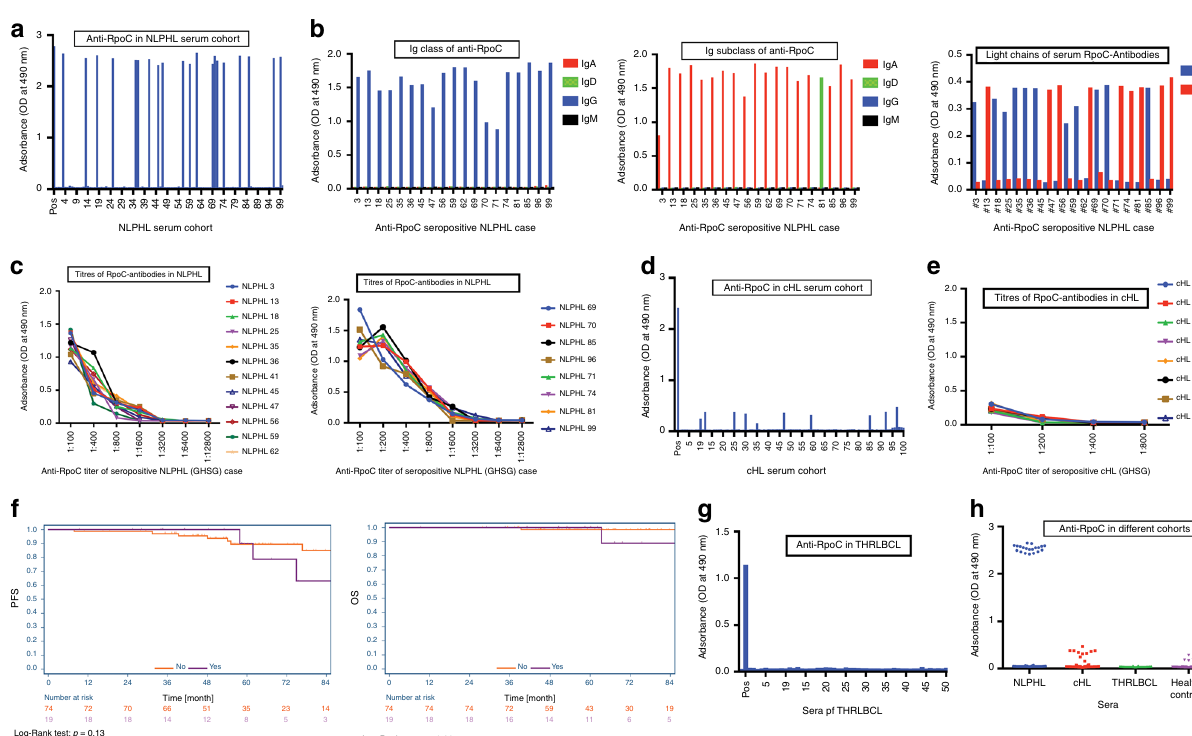
Fig. 2 Serological responses against RpoC of M. catarrhalis in NLPHL, cHL, and THRBCL. a Sera of patients with NLPHL (diluted 1:100) were tested for antibodies against RpoC of M. catarrhalis . b Analysis of Ig classes (left), IgG subclasses (middle), and light chains (right) of serum-antibodies against RpoC of M. catarrhalis in patients with NLPHL. The anti-RpoC antibodies were exclusively of the IgG class, mostly IgG1, and showed light chain restriction. c Titers of anti-RpoC antibodies in seropositive patients with NLPHL. The curves represent OD at 490 nm of different serum dilutions. Patients with NLPHL had titers between 1:800 and 1:3200. d Sera of patients with cHL (diluted 1:100) were tested for antibodies against RpoC of M. catarrhalis . e Seropositive patients with cHL had RpoC-antibody titers of up to 1:200. f PFS and OS of patients with NLPHL with and without RpoC-antibodies. No signi fi cant difference was observed for PFS ( p = 0.13, Log-Rank-test) and OS ( p = 0.26, Log-Rank-test). g Sera of patients with THRBCL (diluted 1:100) were tested for antibodies against RpoC, but all patients with THRBCL were seronegative for RpoC-antibodies. Serum of a seropositive NLPHL patient served as positive control. h Scatter blot for comparison of RpoC-antibodies in sera of patients with NLPHL, cHL, or THRBCL, and healthy controls. Data in a and d are representative of three independent experiments, data in b , c , e , g , and h are representative of two independent